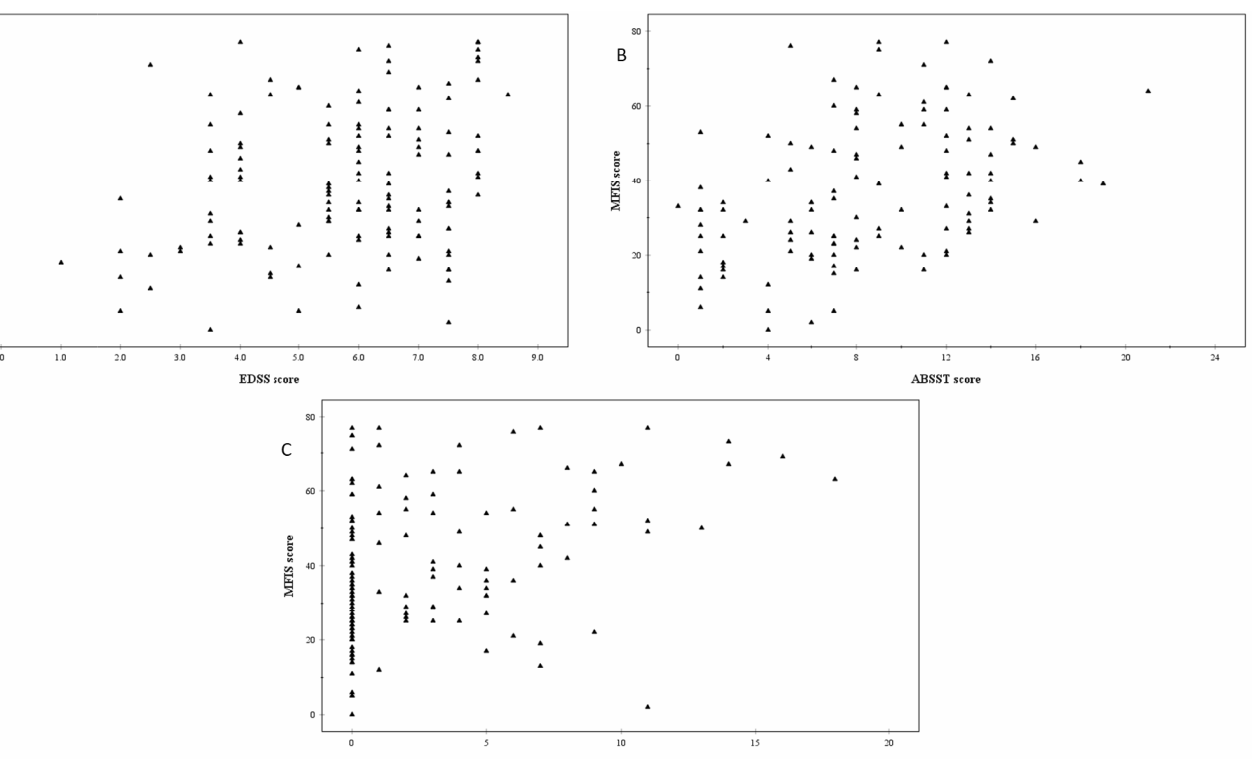
PLOS ONE | https://doi.org/10.1371/journal.pone.0222731 September 19,